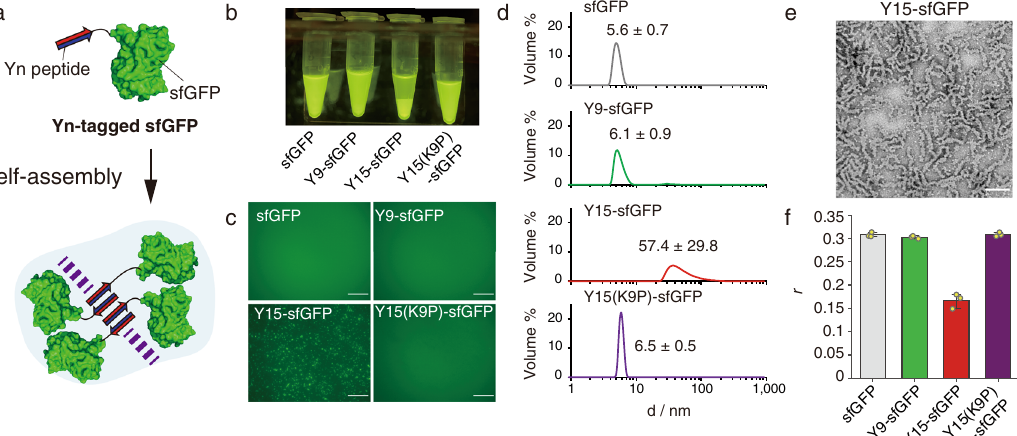
Fig. 2 Self-assembly of Y15-fused sfGFP in test tubes. a Schematic illustration of Yn-tagged sfGFP self-assembly. b A fl uorescence optical image of Yn- sfGFP solutions. The 15 µ M dialyzed proteins in 10 mM phosphate buffer (pH 7.2) with 1 mM EDTA were incubated at 4 °C, resulting in formation of fl uorescent Y15-sfGFP condensates. c Fluorescence microscopy images of protein solutions (1 µ M) in PBS. Scale bar, 100 µ m. d DLS measurements of 5 µ M protein solutions in 10 mM phosphate buffer (pH 7.2). The protein solutions were measured by ZS90 (Malvern) with Zetasizer Software. Y15-sfGFP formed clusters in solution, whereas the other proteins were monomers. e Negative-stained TEM image of Y15-sfGFP. Scale bar, 100 nm. Curly fi brils with a uniform width (13.7 ± 3.2 nm) were observed. f Fluorescence anisotropy assay of 5 µ M protein solutions. Homo-FRET of sfGFP in Y15-sfGFP clusters showed a decrease in fl uorescence anisotropy ( r ). Data are presented as mean values + / − SD ( n = 3 biologically independent experiments). Source data are provided as a Source Data fi